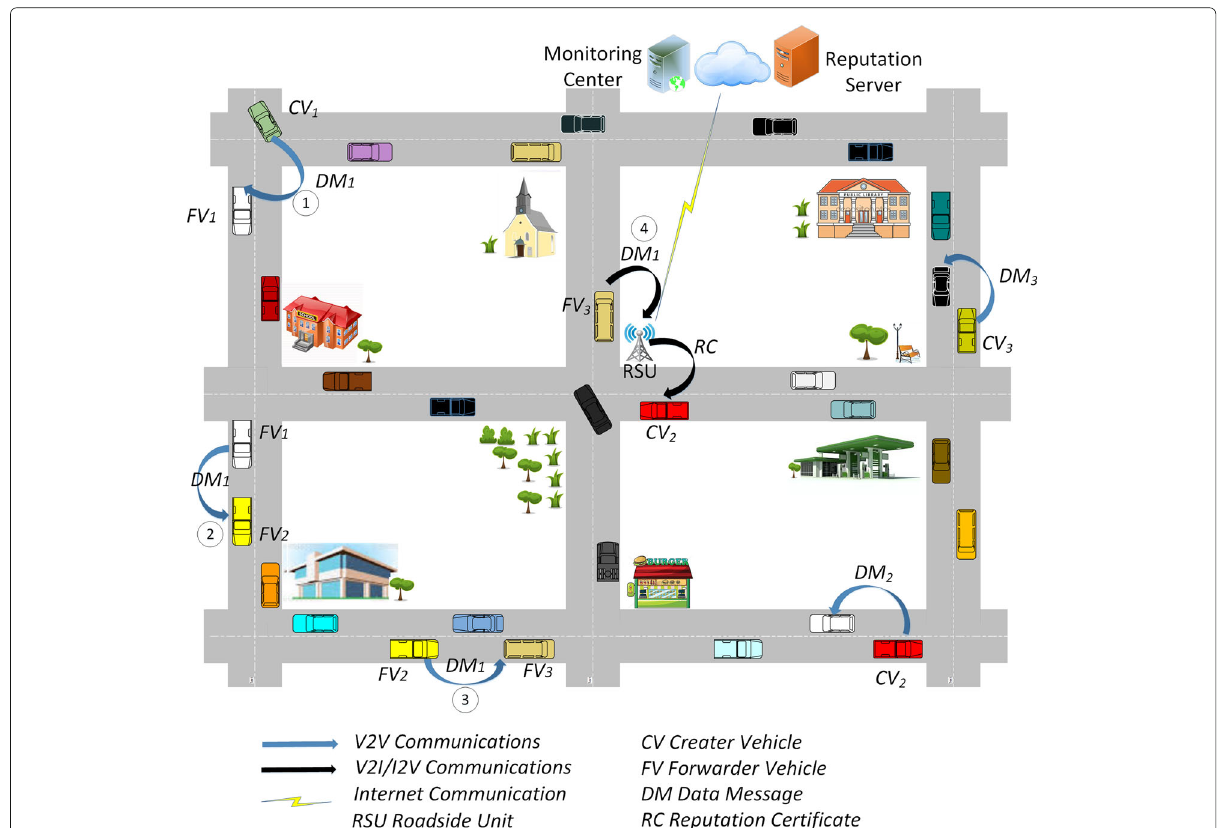
Fig. 6 Motivational scenario: forwarding of messages and sending of feedback to the reputation